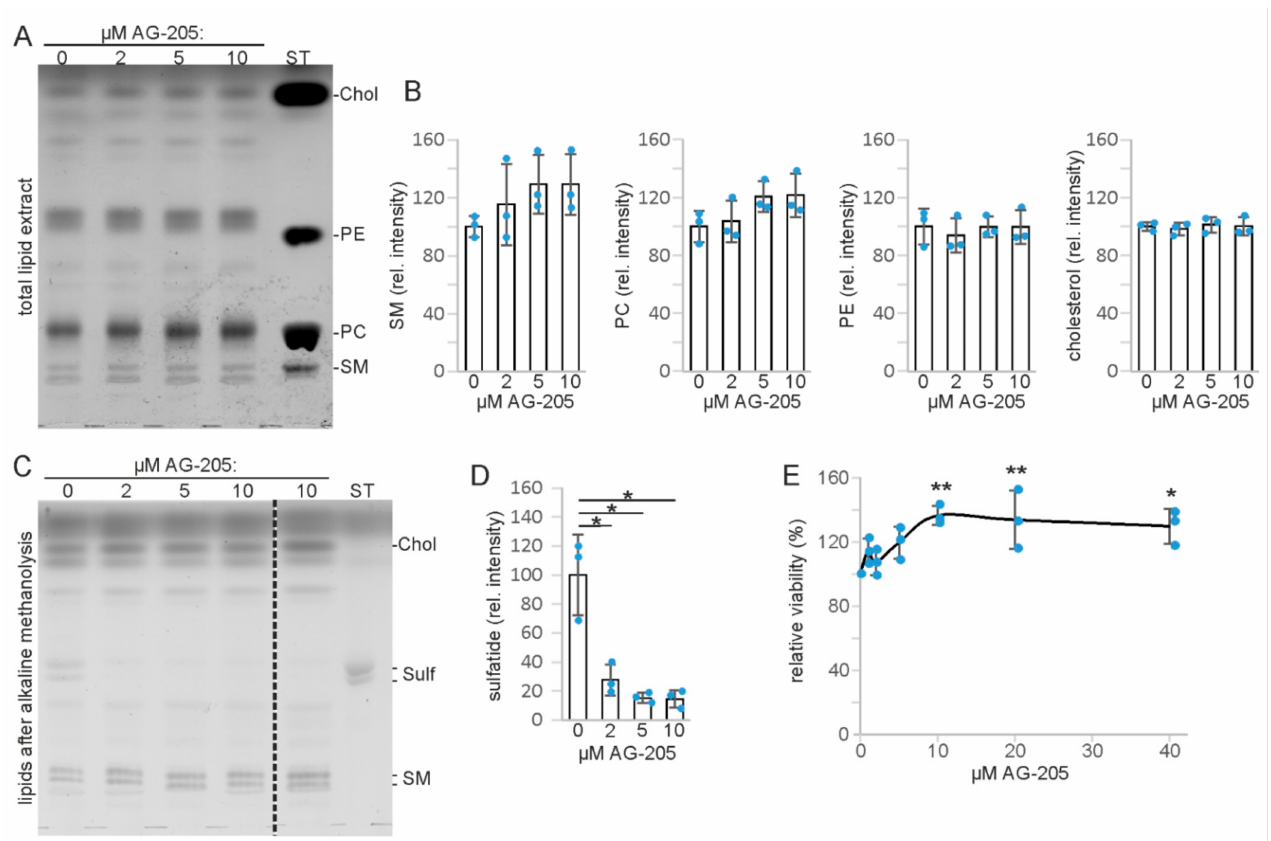
Figure 2. Lipid analysis and cell viability assay of SMKT-R3 cells treated with AG-205. ( A ) TLC analysis of total lipid extracts. Note that the phosphatidyl ethanolamine (PE) standard migrated significantly slower compared to PE in the cell lipid extracts because of the short chain length of the standard lipid. ( B ) Densitometric quantification of sphingomyelin (SM), phosphatidylcholine (PC), phosphatidylethanolamine (PE), and cholesterol (Chol). ( C ) TLC analysis of lipids obtained after alkaline methanolysis of glycerolipids to identify sphingolipids that co-migrate with glycerophospholipids. All lanes shown are from the same TLC plate, though several irrelevant lanes were removed (indicated by the dotted line). Lipid sample in lane 5 were from cells treated with another AG-205 batch. Position of cholesterol (Chol) and sphingomyelin (SM) in this TLC were deduced from the known Rf values. ( D ) Densitometric quantification of sulfatide (Sulf) ( n = 3). * p < 0.05 (one-way ANOVA with post hoc Tukey HSD test). ( E ) MTT cell viability assay. * p < 0.05, ** p < 0.01 (one-way ANOVA with post hoc Dunnett test). Data show the relative cell viability with DMSO-treated cells (0 µ M AG-205) set to 100% ( n = 3). ST, lipid standards. Data are shown with the mean ± SD ( n = 3 independent